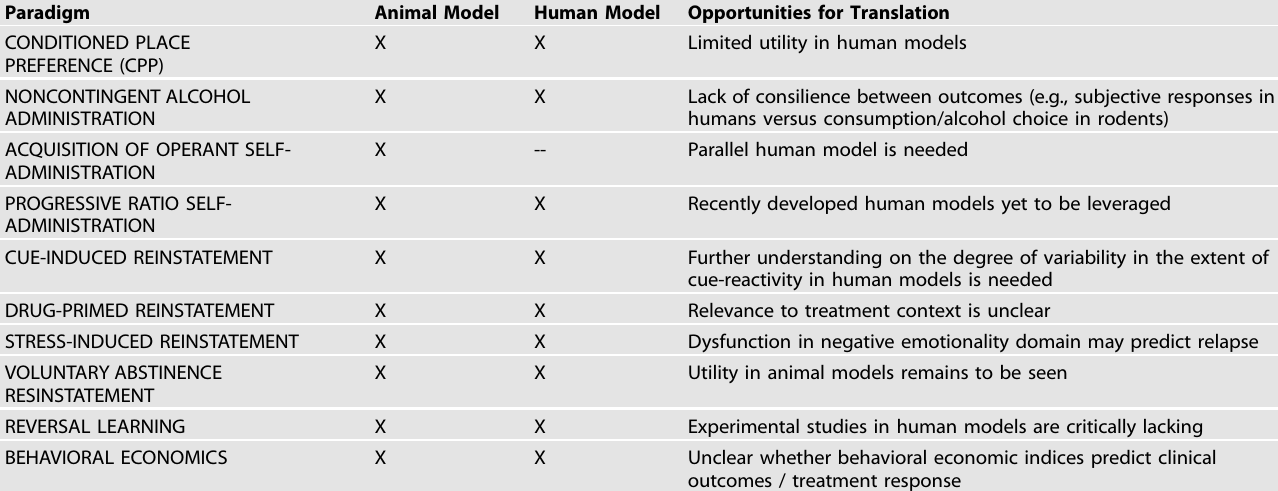
Table 1. Comparison on animal and human models applied to alcohol use